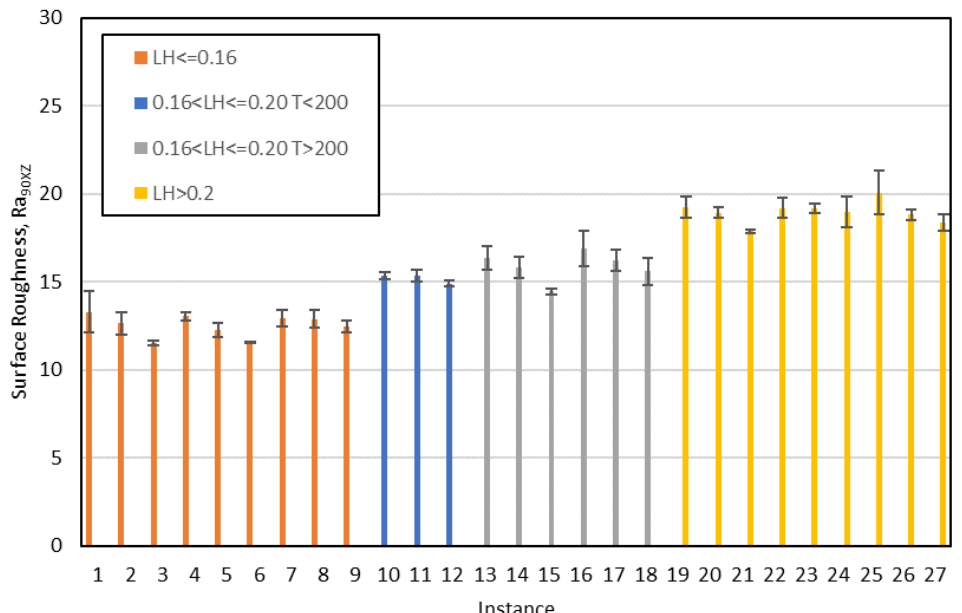
Figure 12. Mean values and standard deviation for R a90XZ ; each color represents a leaf of the decision tree: orange and blue instances belong to class 1; grey and yellow ones belong to class 2 (LH: layer height; T: temperature).